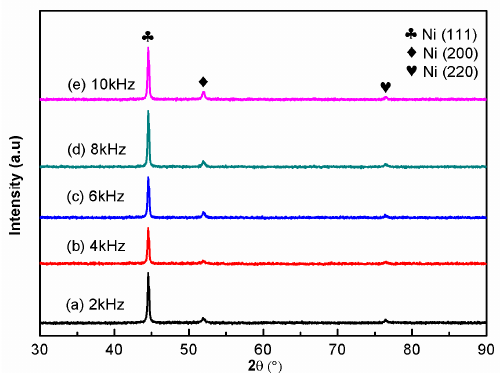
Figure 8. XRD patterns of Ni–Co–BN (h) nanocomposite coatings with varying pulse frequencies: ( a ) 2 kHz, ( b ) 4 kHz, ( c ) 6 kHz, ( d ) 8 kHz, ( e ) 10 kHz.